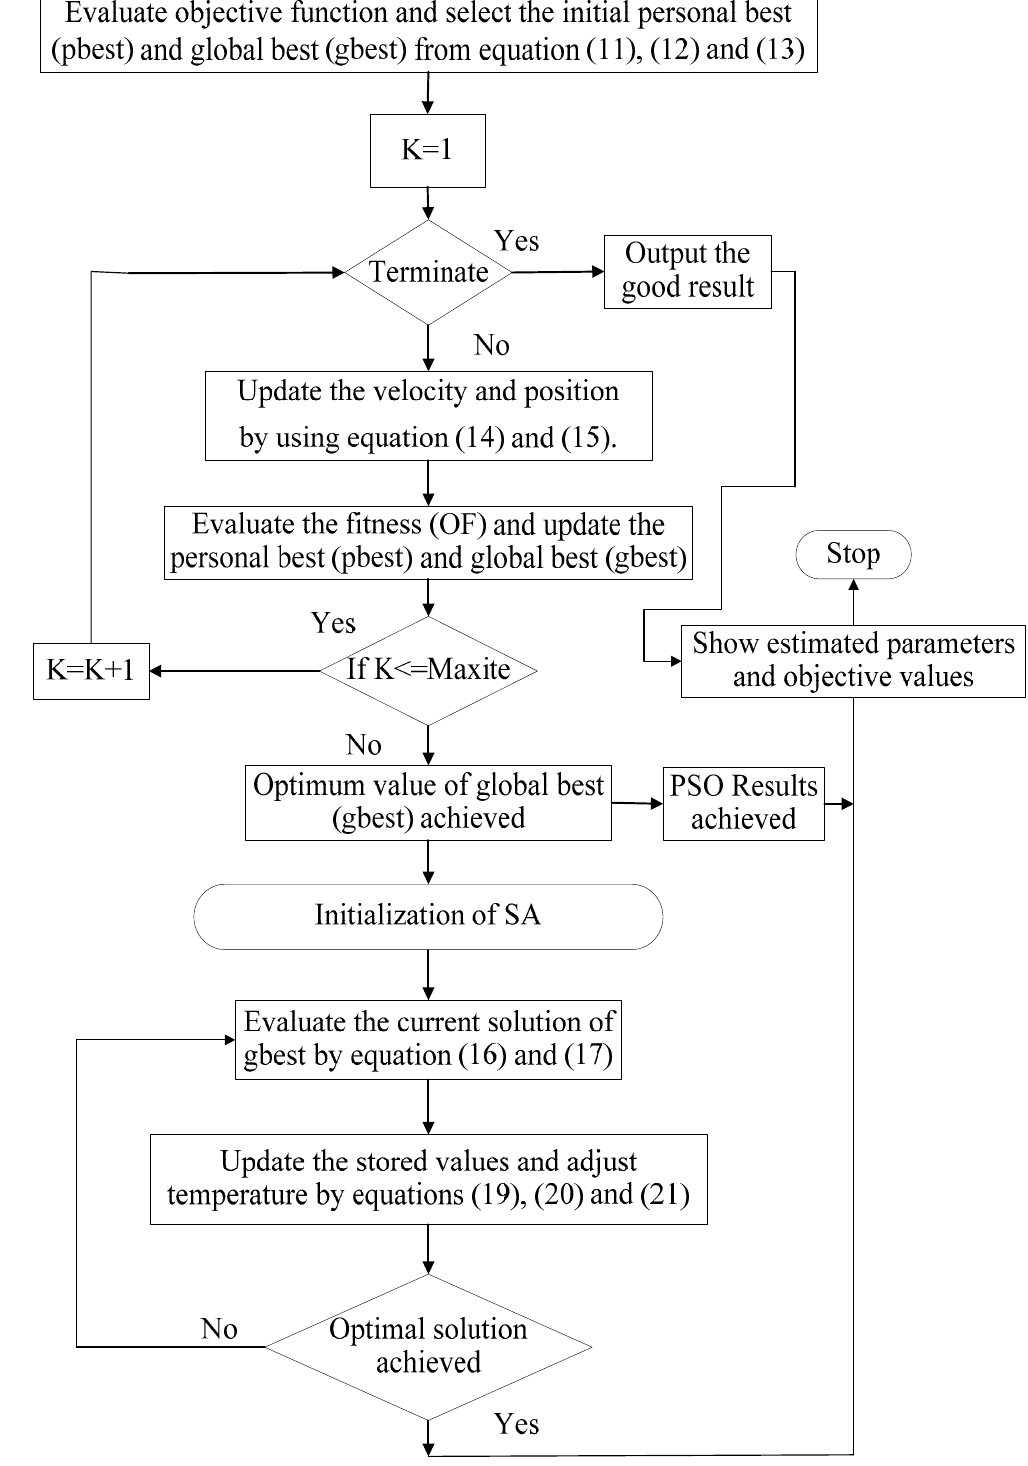
Figure 1. Flow chart of the Proposed Technique.